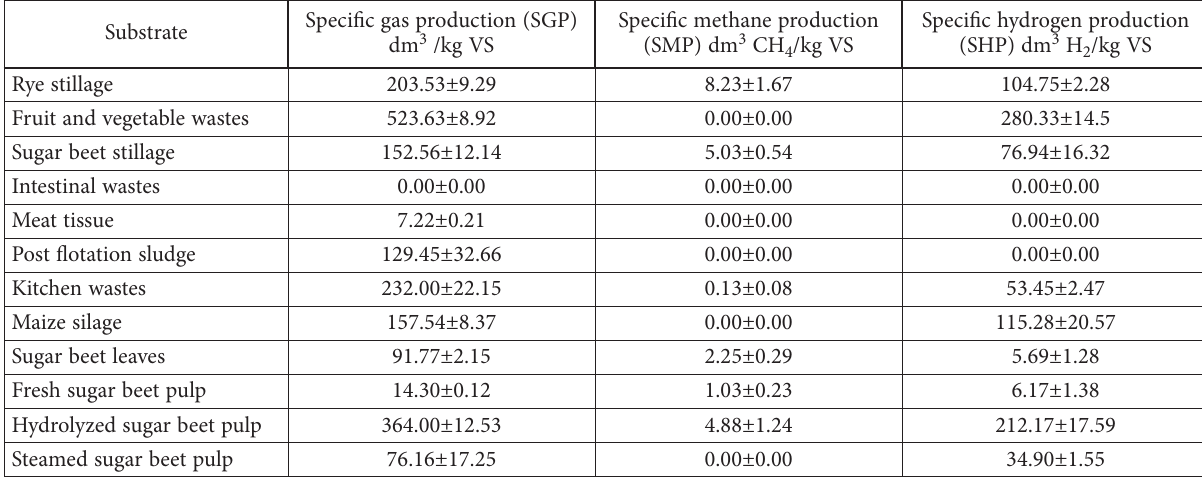
Table 6. Parameters of the batch digestion tests with pH adjustment and thermal